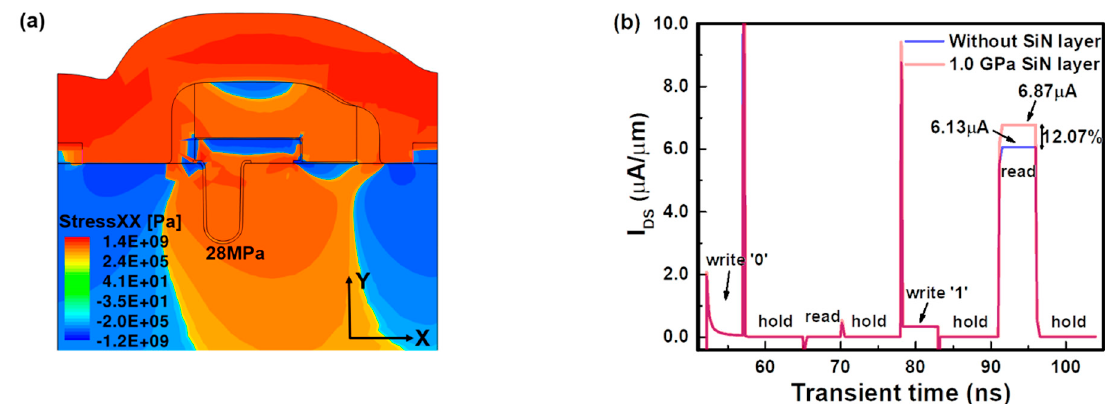
Figure 4. ( a ) Contour of stress XX along the channel direction; ( b ) Simulated drain current enhancement of SFGT memory with the tensive Si 3 N 4 layer during a period of the operation sequence.